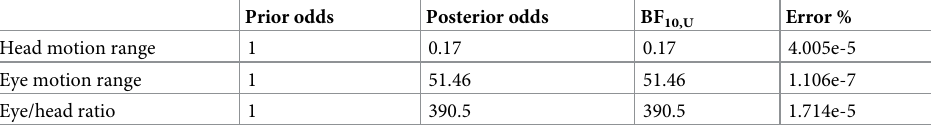
Table 4. Post hoc comparison between rTMS conditions in %